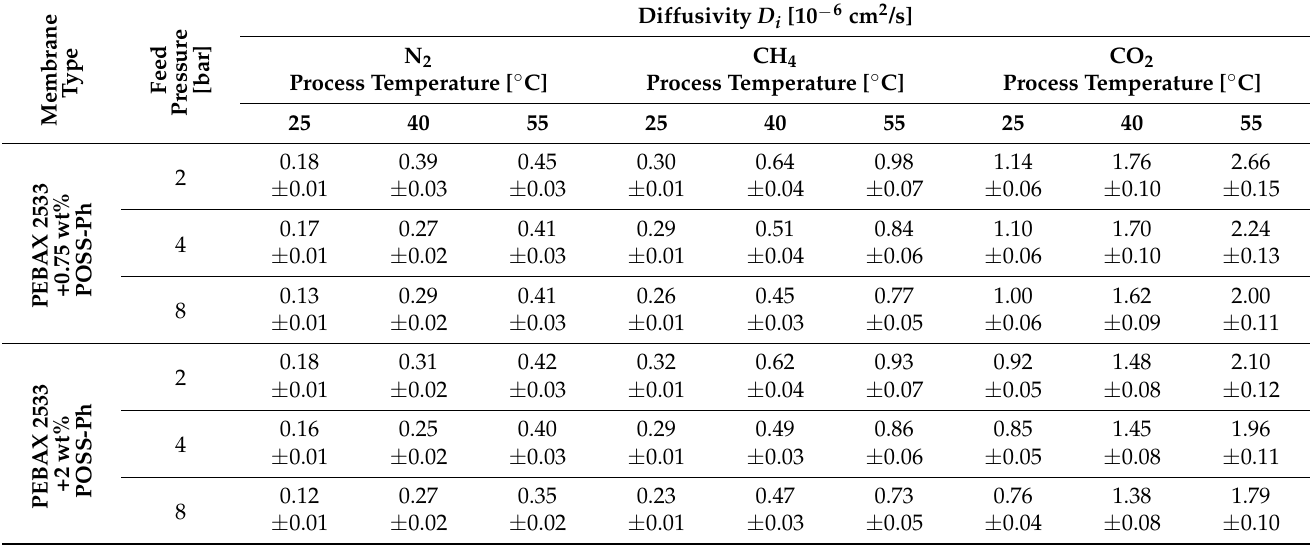
Table A8. Diffusion coefficient of heterogeneous membranes containing POSS-Ph to different gases measured for different feed pressure and temperature values.